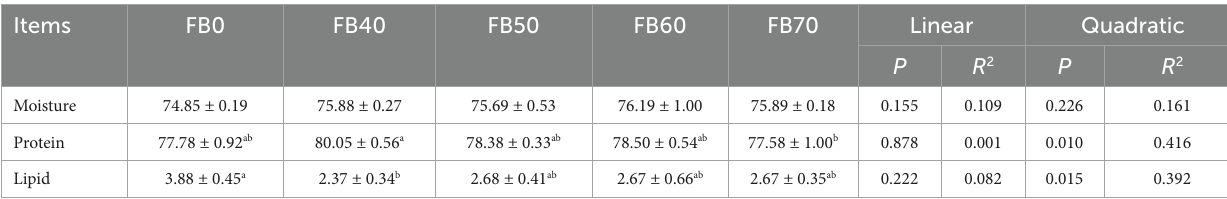
TABLE 3 Effects of dietary faba bean levels on proximate composition (% dry weight) in muscle of tilapia Oreochromis niloticus.